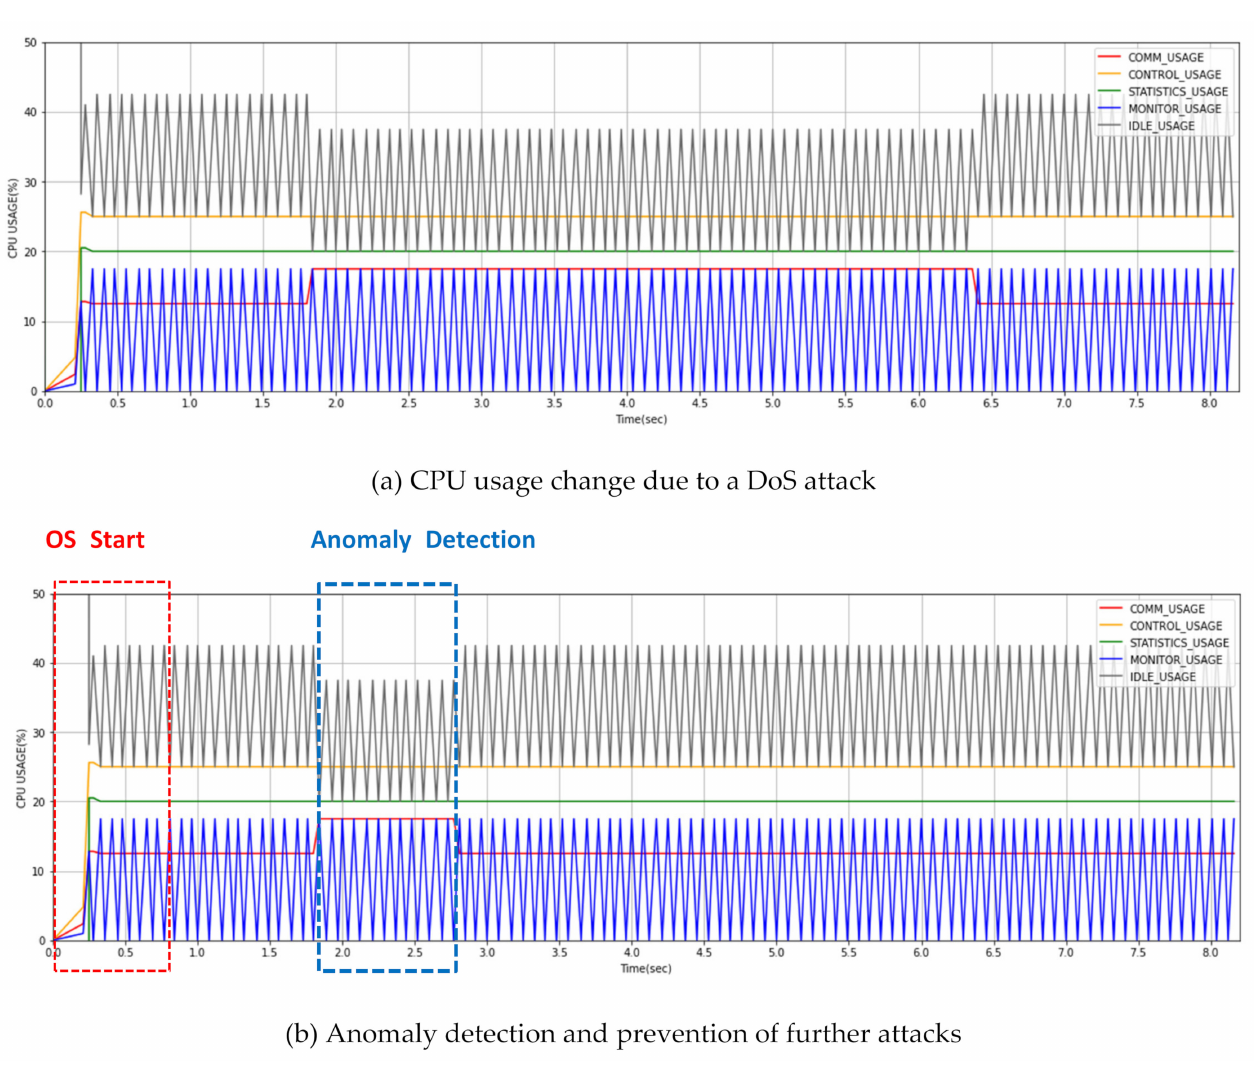
Figure 8. Temporal anomaly detection and